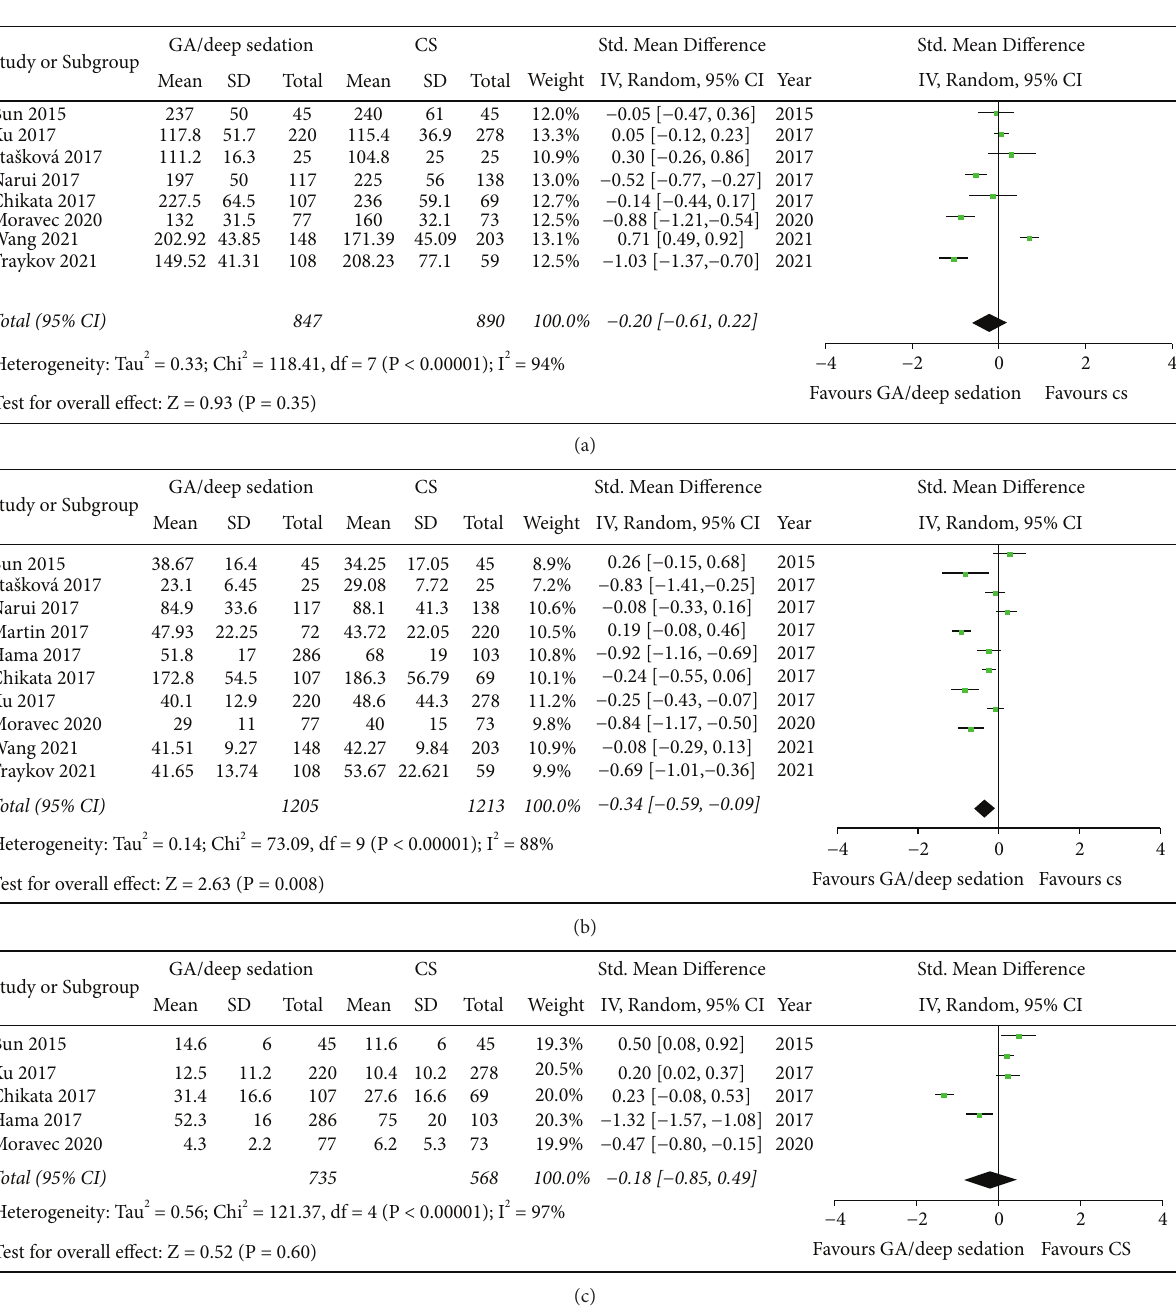
Figure 3: Forest plots comparing (a) mean procedural time of AF ablation, (b) mean ablation time, and (c) mean fluoroscopy time between the GA/deep sedation group and the CS